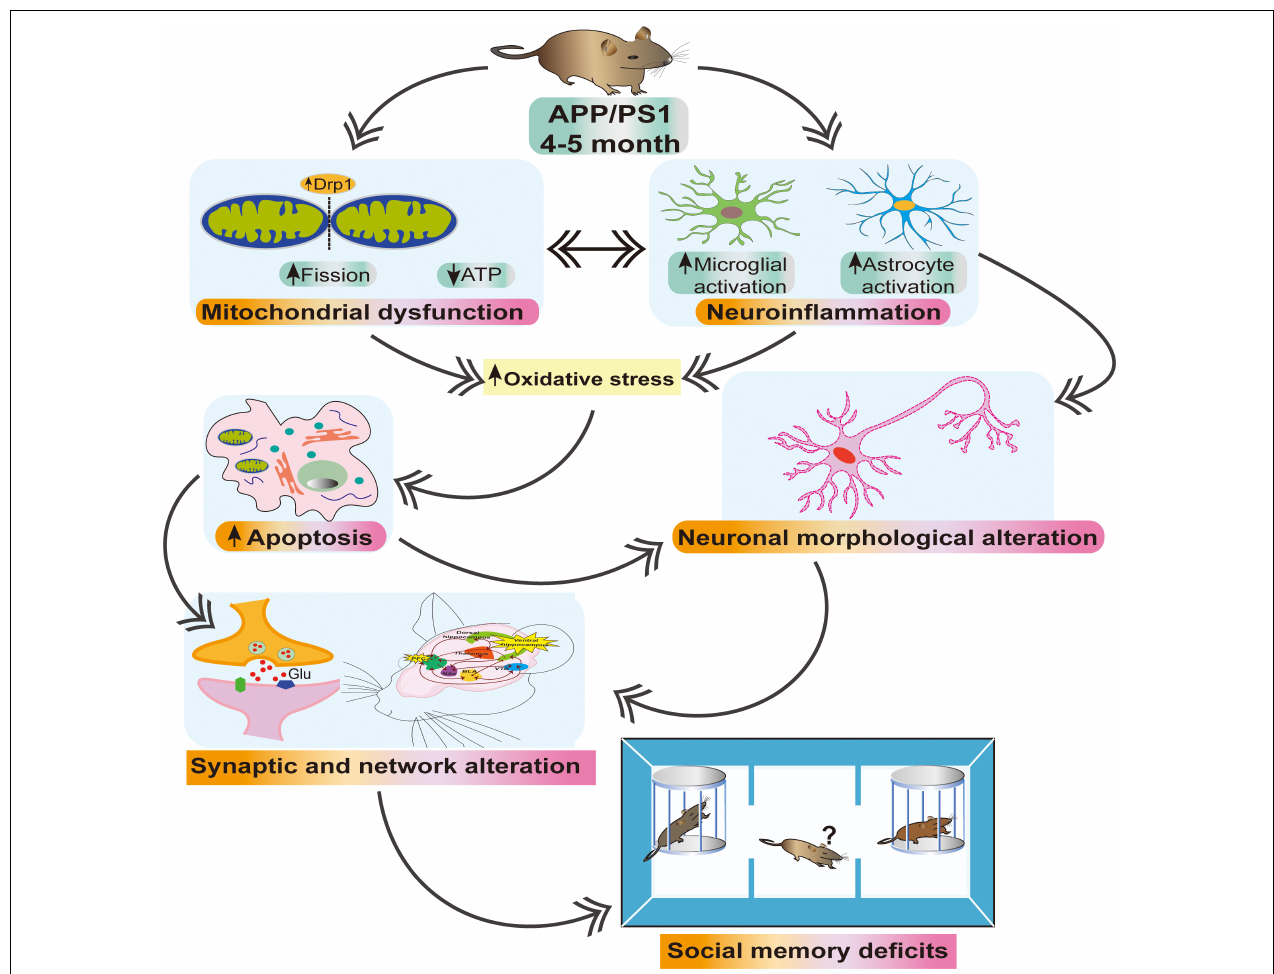
FIGURE 9 | Schematic illustration depicting early alterations in APP/PS1 mice. Increased Drp1 and decreased ATP5A levels in 4 ∼ 5 month-old APP/PS1 ( Figure 1 ) accompanied by astroglial activation ( Figure 6 ), suggesting mitochondrial dysfunction and neuroinflammation likely contribute to oxidative stress,